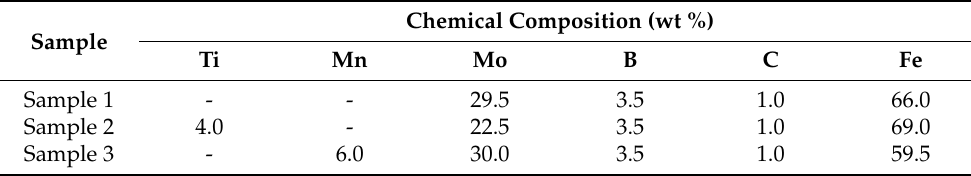
Table 5. Chemical composition of experimental electrodes.